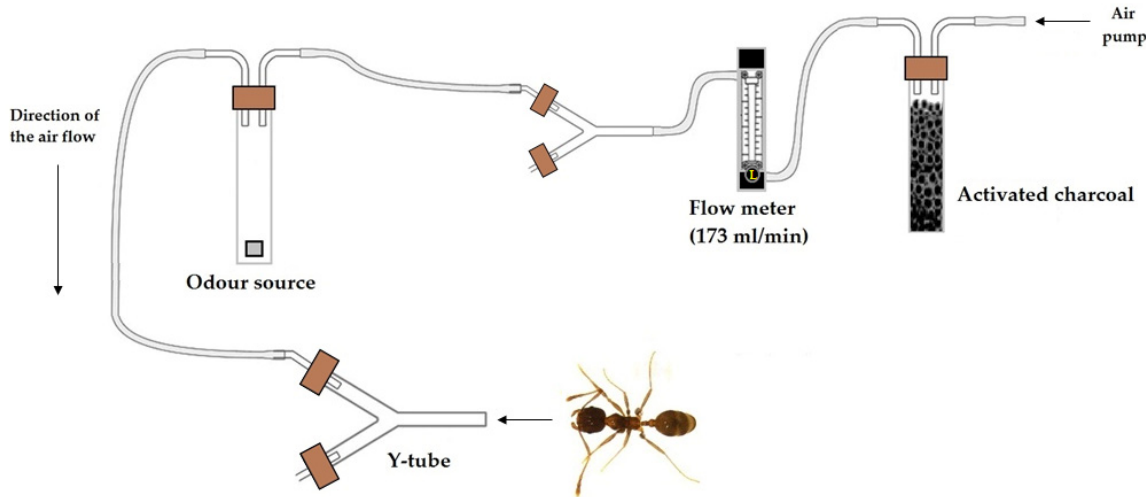
Figure 1. Schematic diagram of the Y-tube olfactometer and experimental setup. This figure is a modification of “Figure 3”, included in the manuscript authored by Saad et al. [46] (doi: 10.1038/srep13697) and licensed under CC BY 4.0 (http://creativecommons.org/licenses/by/4.0/). For all olfactory tests, similar-sized P. pallidula workers from the laboratory colony were used. Each specimen was tested individually by placing it at the base of the Y-tube using a soft paint brush and a 3 min response period. A response was considered